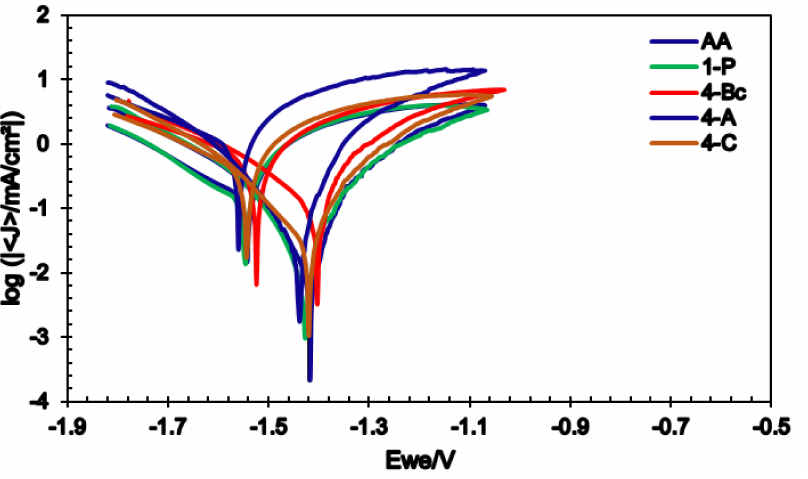
Figure 9. Cyclic potentiodynamic polarization of ZK30 alloy before and after ECAP